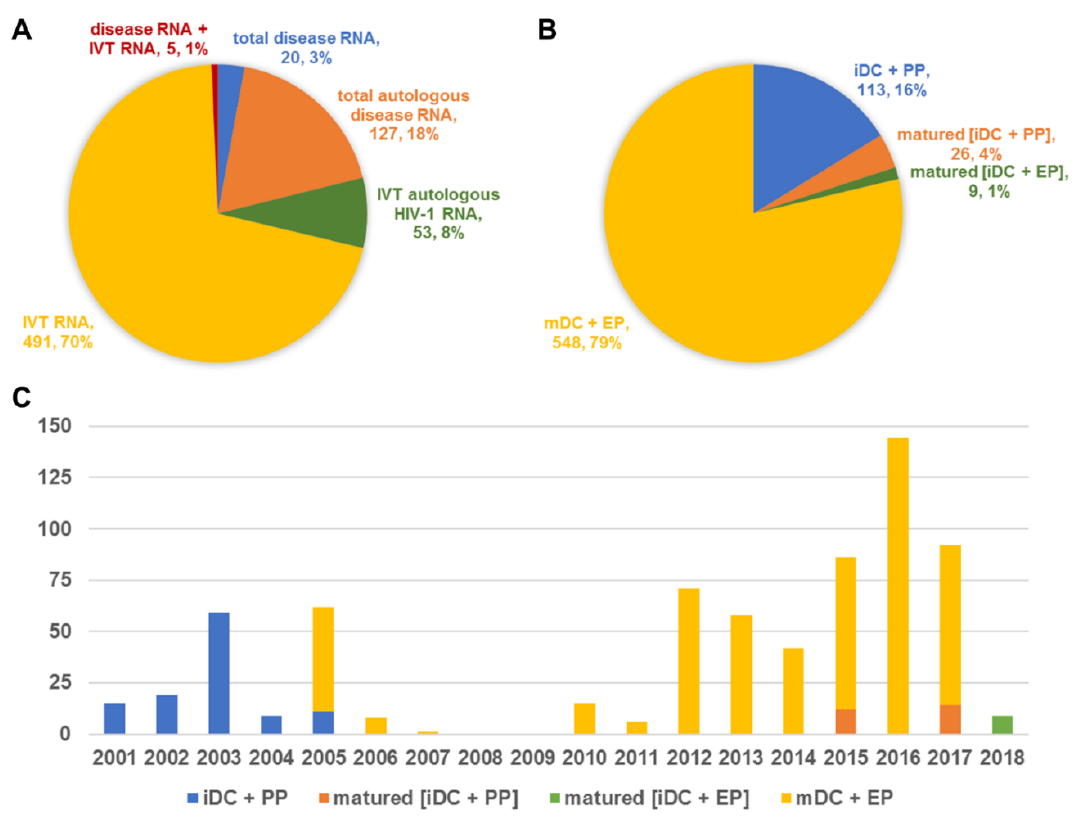
Figure 2. Distribution of all patients vaccinated in clinical trials with RNA-modified dendritic cells per ( A ) RNA source; ( B ) dendritic cell type and RNA loading strategy, including the number and percentage of total ( n = 696), and ( C ) the spreading of the dendritic cell type and RNA loading strategy over time. Abbreviations: EP, electroporation; HIV-1, human immunodeficiency virus-1; iDC, immature dendritic cells; IVT, in vitro transcribed; mDC, mature dendritic cells; PP, passive pulsing; RNA, ribonucleic acid.